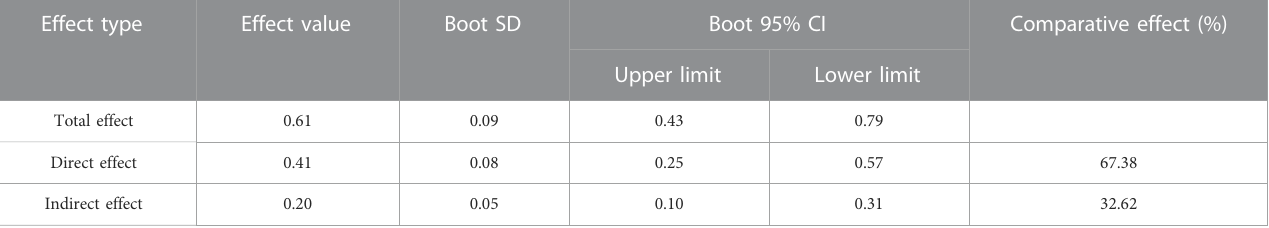
TABLE 4 Analyses of the direct and indirect